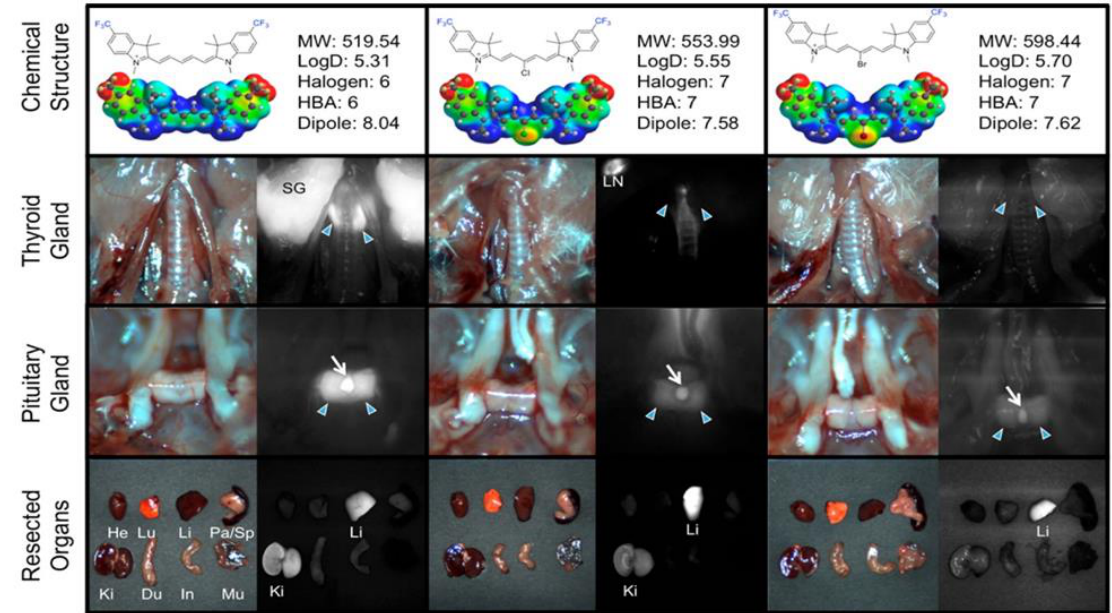
Figure 18. Biodistribution studies for compounds 131 – 133 indicating thyroid and pituitary gland targeting. Each mouse model was injected with 10 mM of the respective fluorophores: 131 ( left ), 132 ( middle ), and 133 ( right ). Arrow heads indicate the anterior portion and arrows for posterior pituitary. Figure used with permission from [79]. Copyright 2016 American Chemical Society.